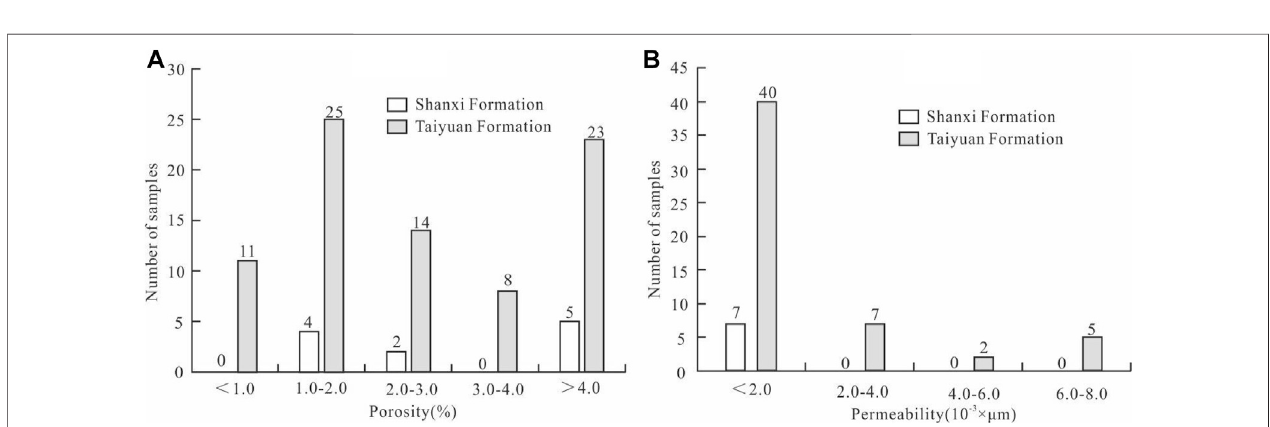
FIGURE 9 | Porosity distribution and permeability distribution of the mudshale.